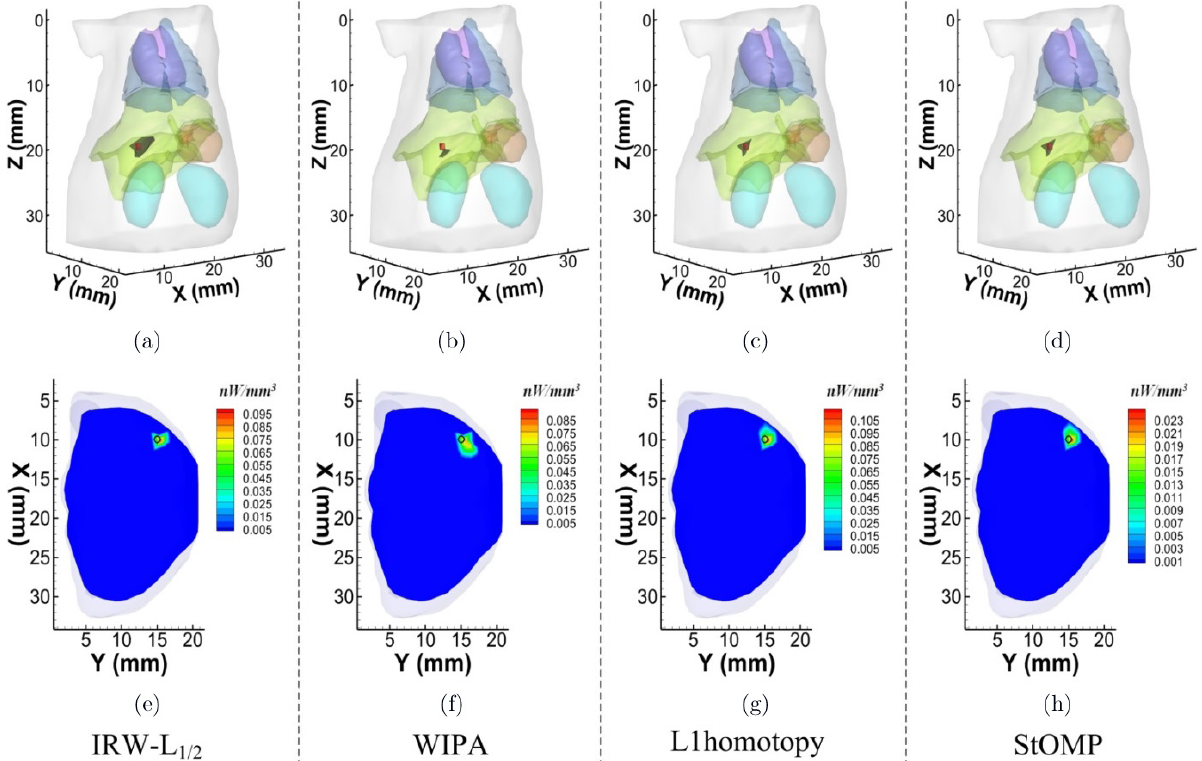
Fig. 3. Reconstruction results by the four algorithms in single-source simulation. The top row shows the 3D views of results by IRW-L 1 = 2 , WIPA, L1 homotopy and StOMP, respectively. The bottom row shows the corresponding transverse views at z ¼ 18 mm, where the actual source center located.